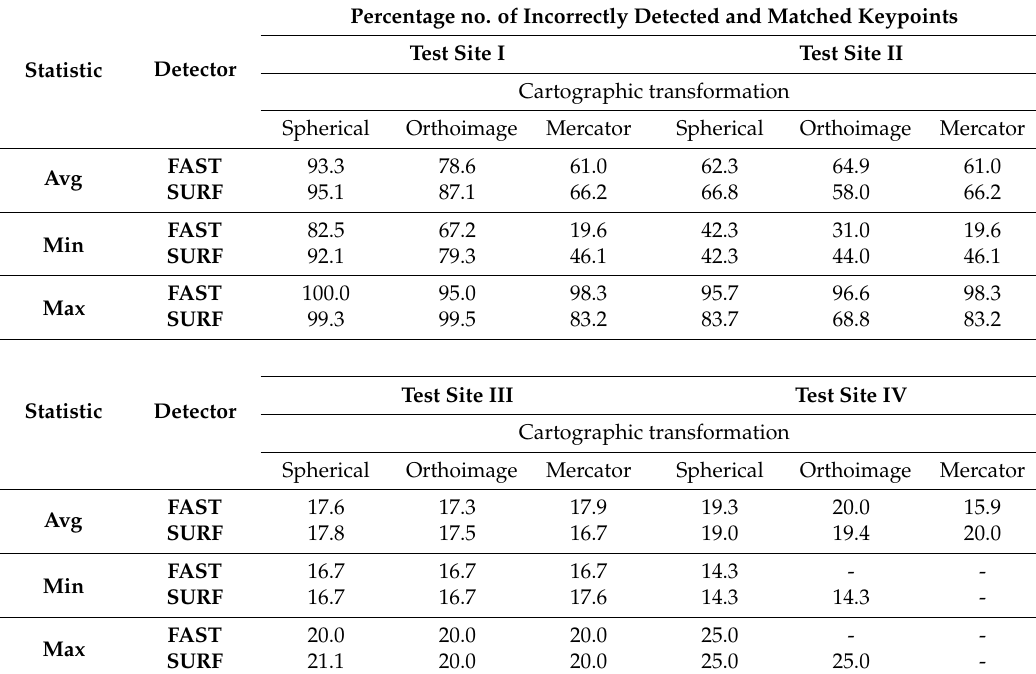
Table 4. The percentage number of incorrectly detected and matched keypoints for particular projections of point clouds for all test sites (both